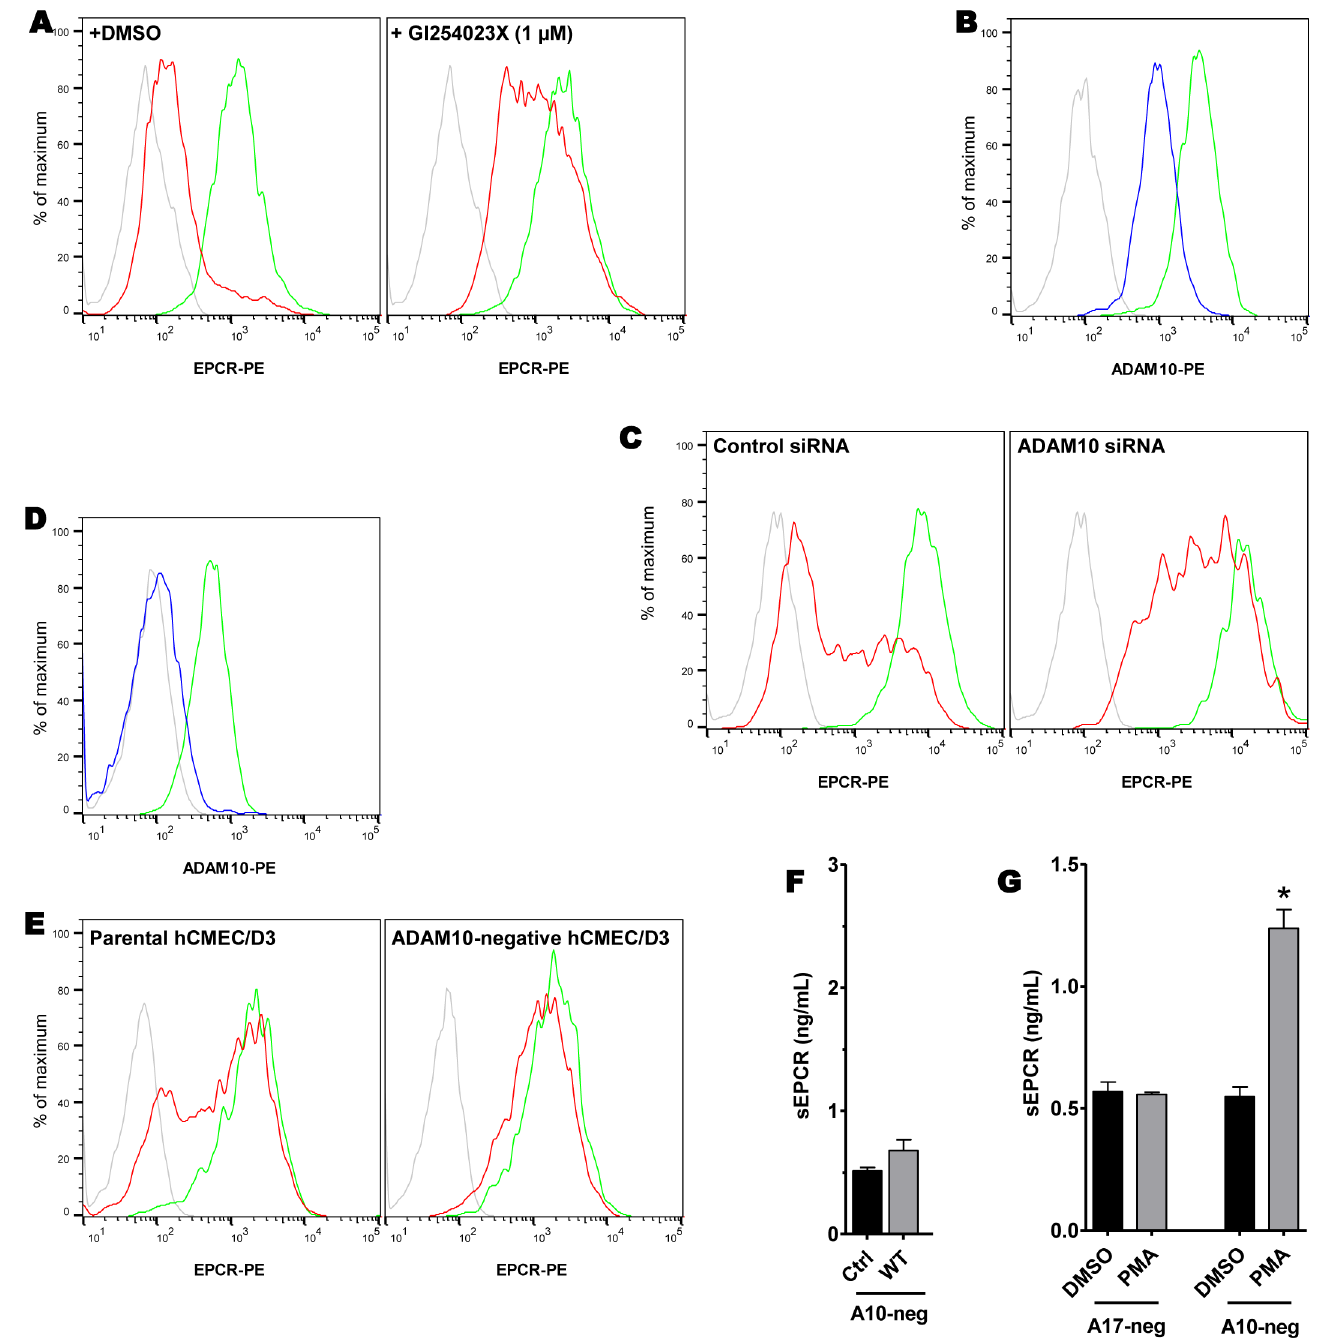
Fig 6. The EPCR shedding induced by meningococcus is mediated by ADAM10. ( A ) HDMEC were treated with the ADAM10 inhibitor GI254023X (1μM, right), or DMSO only (left) and were infected for 4h by a wild-type adherent N . meningitidis (red) or left non-infected (green). EPCR expression was assessed by a FACS analysis (grey: isotype control). Data are representative of 3 independent experiments. For the quantification of EPCR expression see supplemental data S1 Fig . (B) ADAM10 membranous expression of HDMEC cells transfected with a siRNA against ADAM10 (blue) or control (green). Grey: isotype control. For the quantification of ADAM10 expression see supplemental data S3 Fig . (C) EPCR expression by HDMEC cells transfected with either a control siRNA (left) or ADAM10 siRNA (right) and infected with a WT N . meningitidis strain for 4 hours (red) or left non-infected (green). Grey: isotype control. For the quantification of EPCR expression see supplemental data S3 Fig . A Crispr/Cas9-mediated knockdown of ADAM10 expression was performed in hCMEC/D3 as described in the Material and Methods section. ( D ) ADAM10 expression in the resulting cell line (blue) compared to that of the parental cell line (green). (E) EPCR expression in the parental hCMEC/D3 cell line (left) or ADAM10-negative-hCMEC/D3 cell line (right) and infected with a WT N . meningitidis strain for 4 hours (red) or left non-infected (green). Data are representative of 3 independent experiments. (grey: isotype control). For the quantification of EPCR expression see supplemental